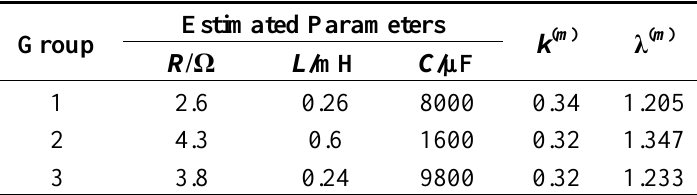
Table 4. Overload coefficients and estimated parameters.